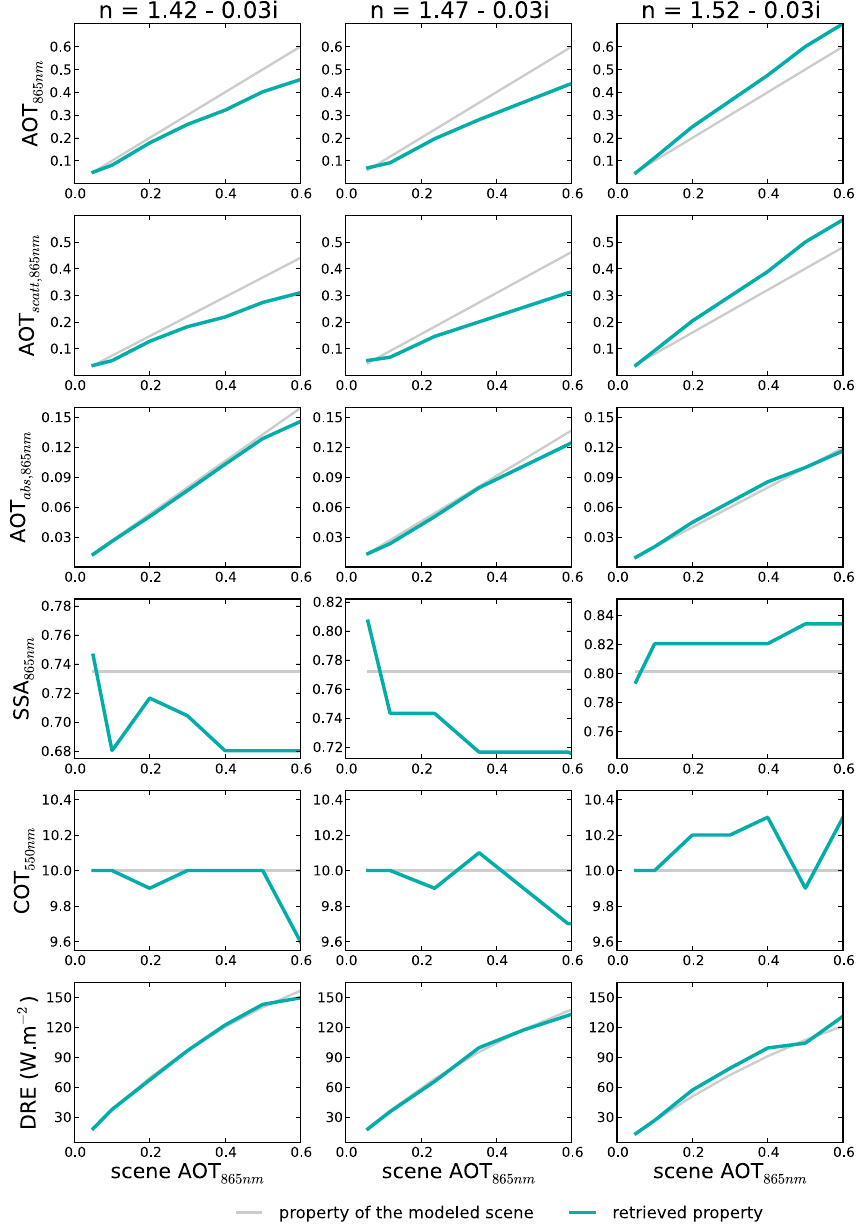
Figure 5. Sensitivity of the properties of ACA conditions with different aerosol models. From top to the bottom: total AOT, scattering AOT, absorption AOT and SSA at 865nm, COT at 550nm and the shortwave DRE of aerosols. Grey lines correspond to the properties of the actual modeled conditions and green lines to those retrieved by the algorithm. The aerosol model of the first column has a refractive index n equal to 1.42 − 0.03 i , the second, n = 1.47 − 0.03 i and the third, n = 1.52 − 0.03 i . Aerosols have an effective radius of 0.1µm and the effective radius of the cloud water droplets is